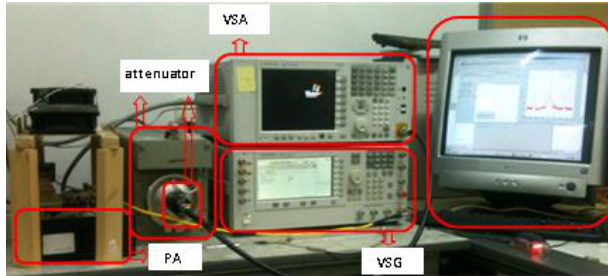
Fig. 2 Measurement Setup